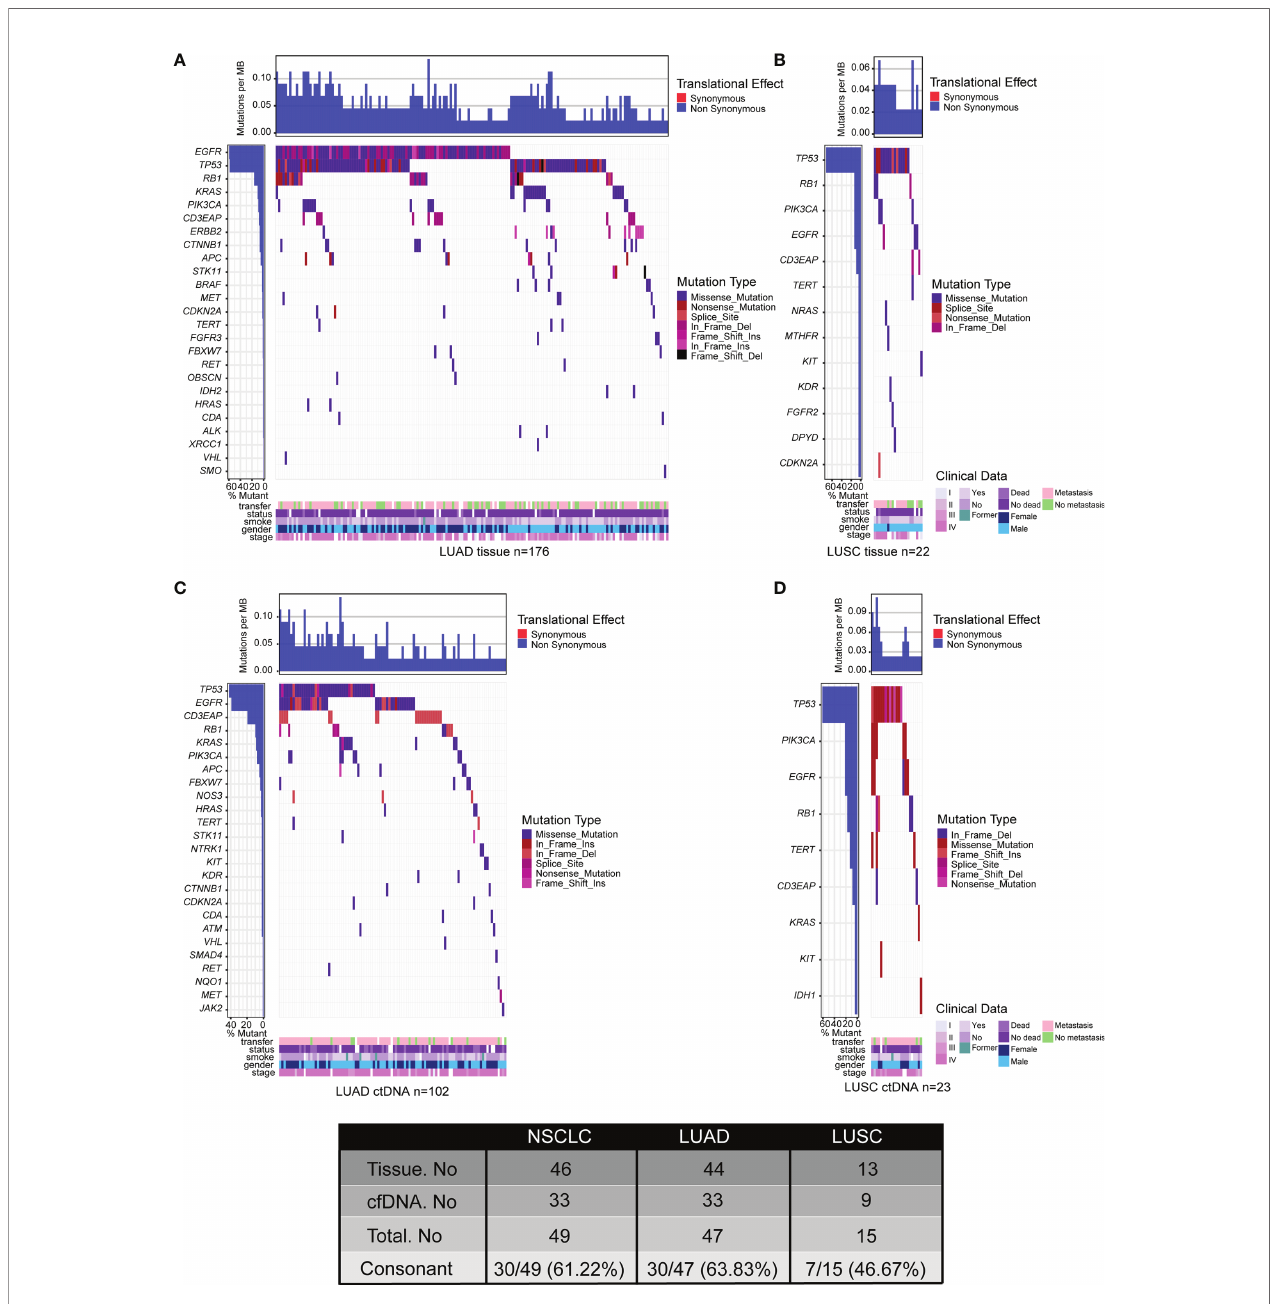
FIGURE 3 | Tumor mutation landscape of NSCLC derived from LUAD tumor tissue DNA (n = 197) (A) , LUSC tumor tissue DNA (n = 23) (B) , LUAD ctDNA (n = 143) (C) , and LUSC ctDNA (n = 31) (D) . Patients were arranged along the x-axis. Signi fi cantly mutated genes identi fi ed by VarDict were ranked by mutation frequencies and clinical characteristics. Tumor mutation burden (TMB, mutations per Mb) is shown in the upper panel. The bars on the left represent the mutation frequency of each